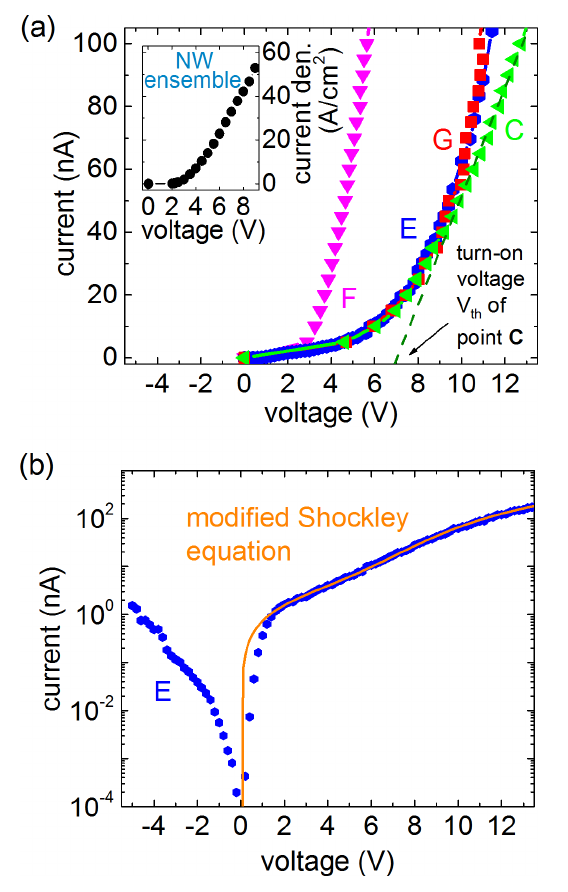
Figure 5: (a) I – V characteristic of points C, E, F, and G. The dashed line shows an example for a linear fit to the I – V curve of NW C for the current range from 60 to 100 nA from which the series resistance R tot and the threshold voltage V th are derived. The inset depicts the I – V be- havior of the ensemble. (b) Semi-log plot of the I – V curve (blue dots) of NW E and the respective fit (orange line) of the data, obtained by using Equation